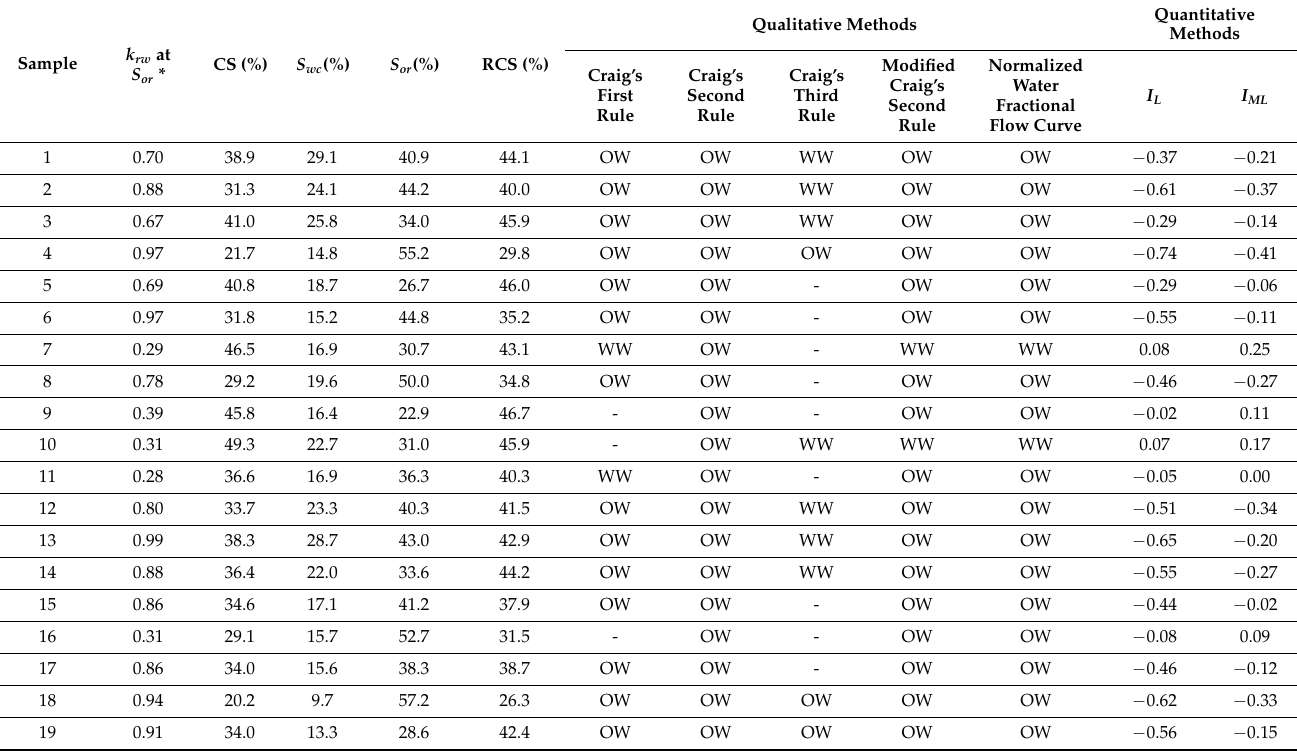
Table 4. Results of wettability evaluation by the relative permeability-based